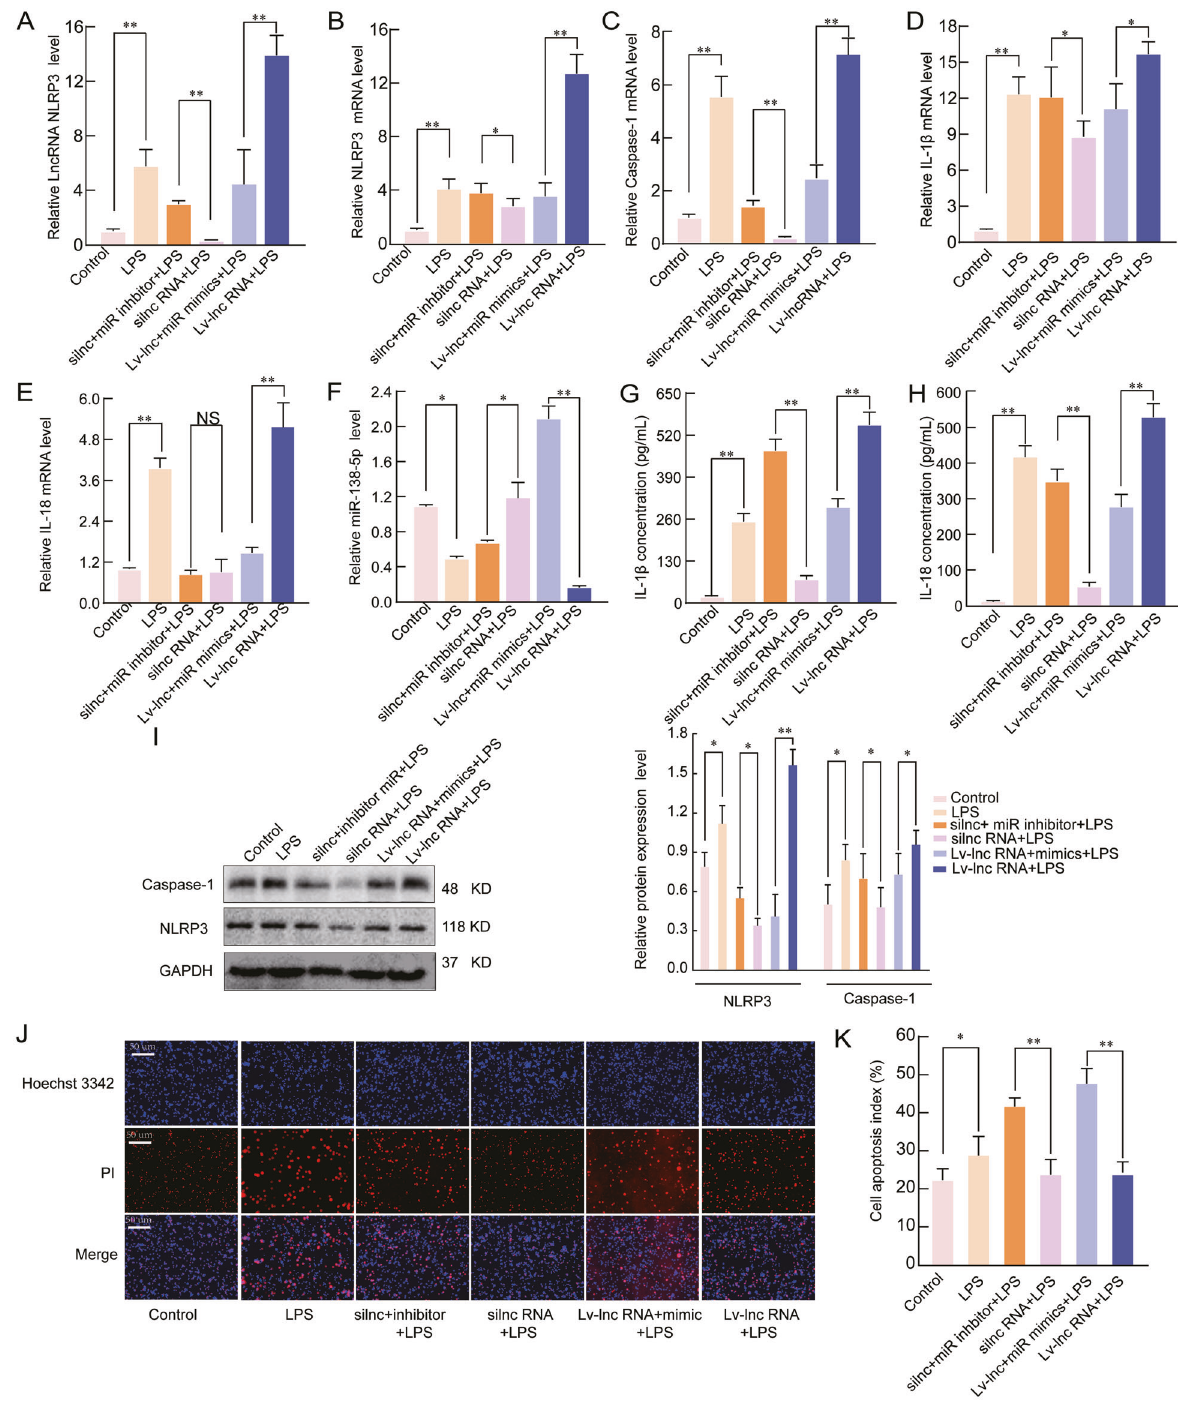
Fig. 6 LncRNA NLRP3 regulates the in fl ammatory response through the lncRNA NLRP3/miR-138-5p/NLRP3 ceRNET in vitro. miR-138-5p suppression reversed the effects of silncRNA NLRP3 on the mRNA expression of A lncRNA NLRP3, B NLRP3, C Caspase-1, D IL-1 β , E IL-18, and F miR-138-5p in NR8383 alveolar macrophage (AMs) cells. β -Actin was used as the reference gene. G , H ELISA analysis of the IL-1 β and IL-18 levels in the culture supernatant. I Western blotting assay of the protein expression levels of NLRP3 and caspase-1. J , K Cell apoptosis was determined by Hoechst 33342 and PI dual staining assays ( J ) and counted ( K ). The data are presented as mean ± SE ( n = 6). * P < 0.05; ** P < 0.01; *** P < 0.001; NS, no statistically signi fi cant